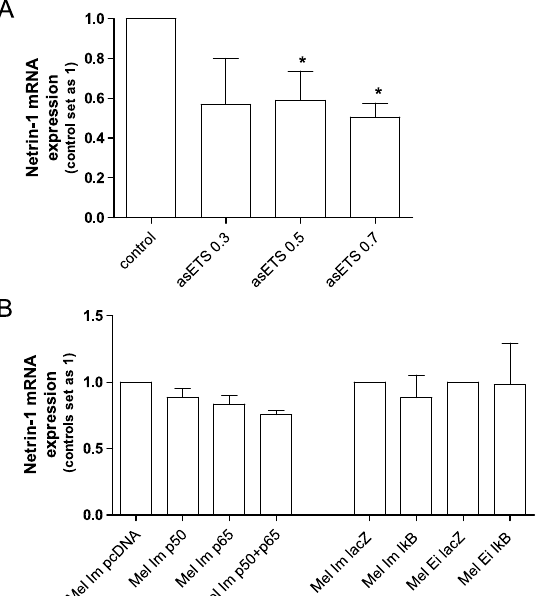
Fig. 2. Regulation of Netrin-1 expression. (A) Mel Im cells were transiently transfected with different amounts of antisense Ets-1 ex- pression construct. Regulation of Netrin-1 mRNA was assessed by quantitative RT-PCR 48 h after transfection compared with the mock transfected control. (B) Mel Im cells were either transfected with ex- pression plasmids for p50, p65 or both, or transduced with an aden- oviral vector expressing a stable form of I κ B. Regulation of Netrin-1 mRNA was assessed by quantitative RT-PCR 48 h after transfec- tion/transduction compared with the mock control. All experiments were performed in triplicate and repeated three times with similar results, bars display mean + SD, statistical analysis was performed using a Student’s unpaired t -test. (* p < 0 . 05.)